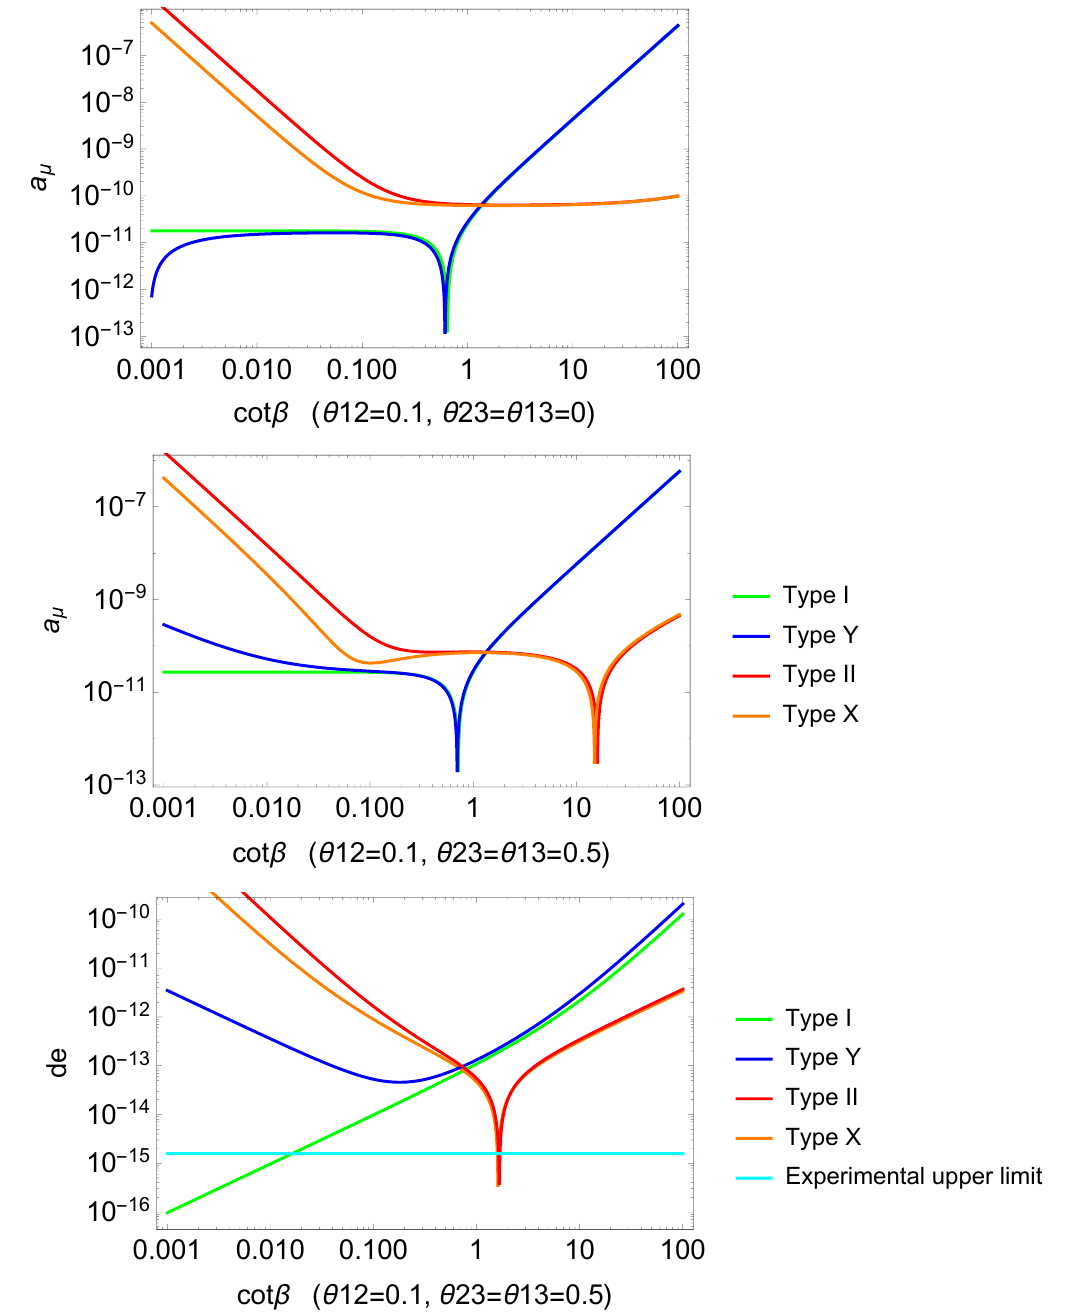
Figure 13 . a (cid:22) (top) and d e (bottom) values in di(cid:11)erent 2HDM Types for (cid:12)xed values of angles and masses ( m h = 200 ; 50 2 ; 3